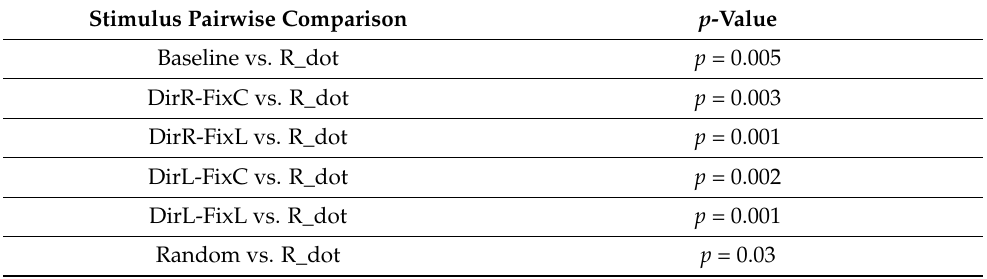
Table 1. Significant values resulting from the Bonferroni pairwise comparison for the microsac- cade peak velocity. Please note that for simplicity only significant comparisons are reported.